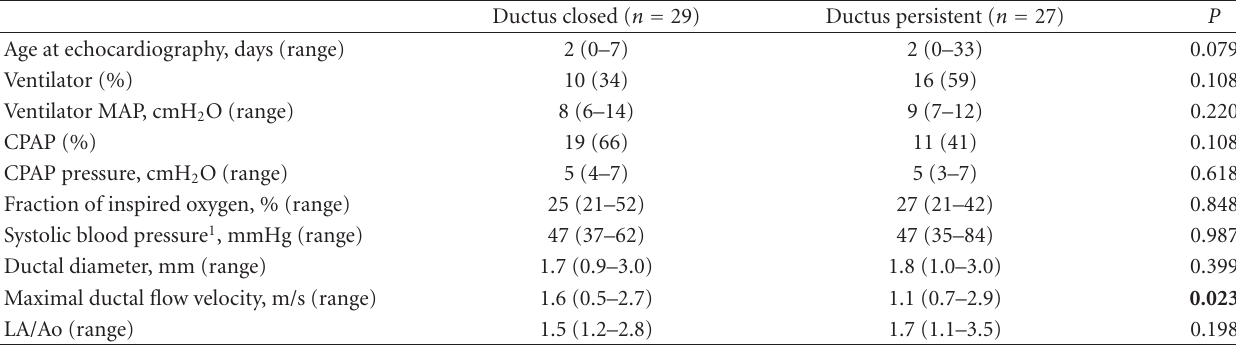
Table 2: Characteristics at time of echocardiography.